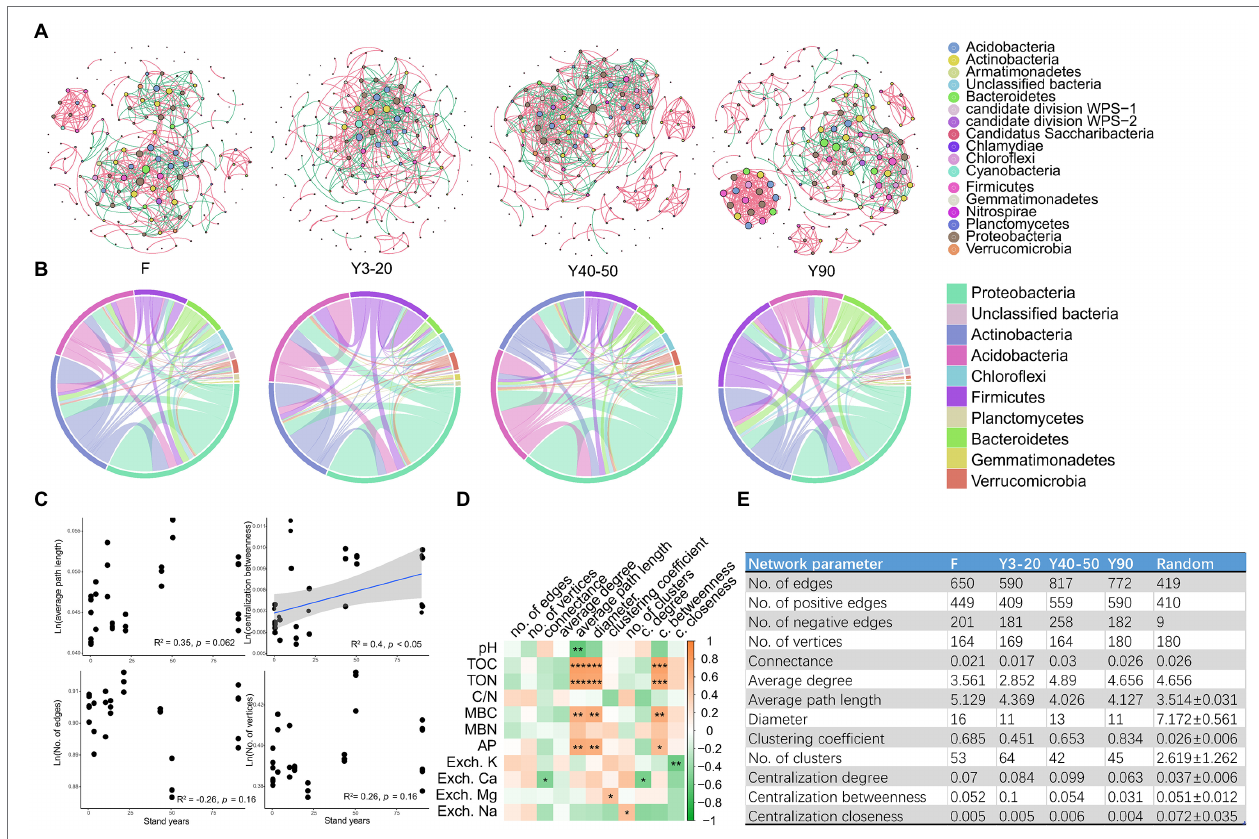
FIGURE 5 | (A) The co-occurrence networks visualize the effects of varying stand ages of tea plantations (Y3–20, Y40–50, and Y90) and the adjacent forest (F) on the co-occurrence pattern between soil bacterial taxa at family level. The node size is proportional to the abundance of taxa, and the nodes represent bacterial taxa at the family level. The edges are colored according to interaction types; positive correlations are labeled with green, and negative correlations are colored in pink. (B) CIRCOS plots showing the distribution of links among the top 10 interacting phyla in networks Y3–20, Y40–50, Y90, and F. (C) Linear regression relationships between tea stand ages and key topological parameters (ln-transformed) of all subnetworks (average path length, centralization betweenness, no. of edges, and no. of vertices). (D) Spearman’s correlations between soil physicochemical properties and topological parameters in all subnetworks. Significant correlations are marked by * p < 0.05, ** p < 0.01, and *** p < 0.001. (E) Topological parameters of the networks Y3–20, Y40–50, Y90, and